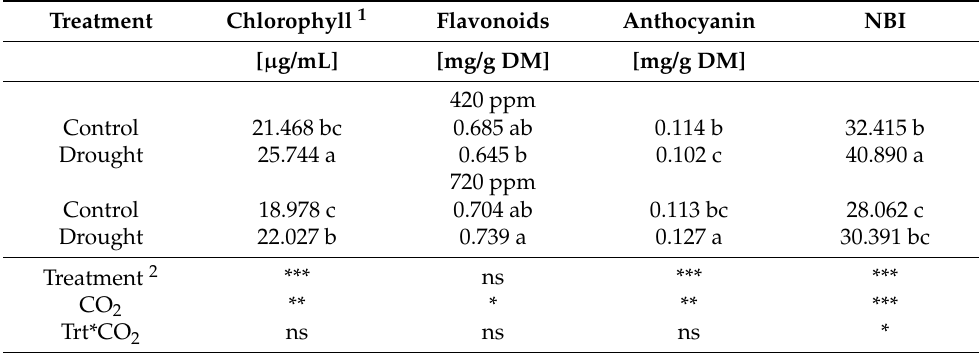
Table 1. The mean of chlorophyll (Chl), flavonoids (Fla), anthocyanin (Antho), and nitrogen balance index (NBI) of basil plants grown without drought stress (control) and with drought stress at two levels of CO 2 (420 and 720 ppm) after 17 days of